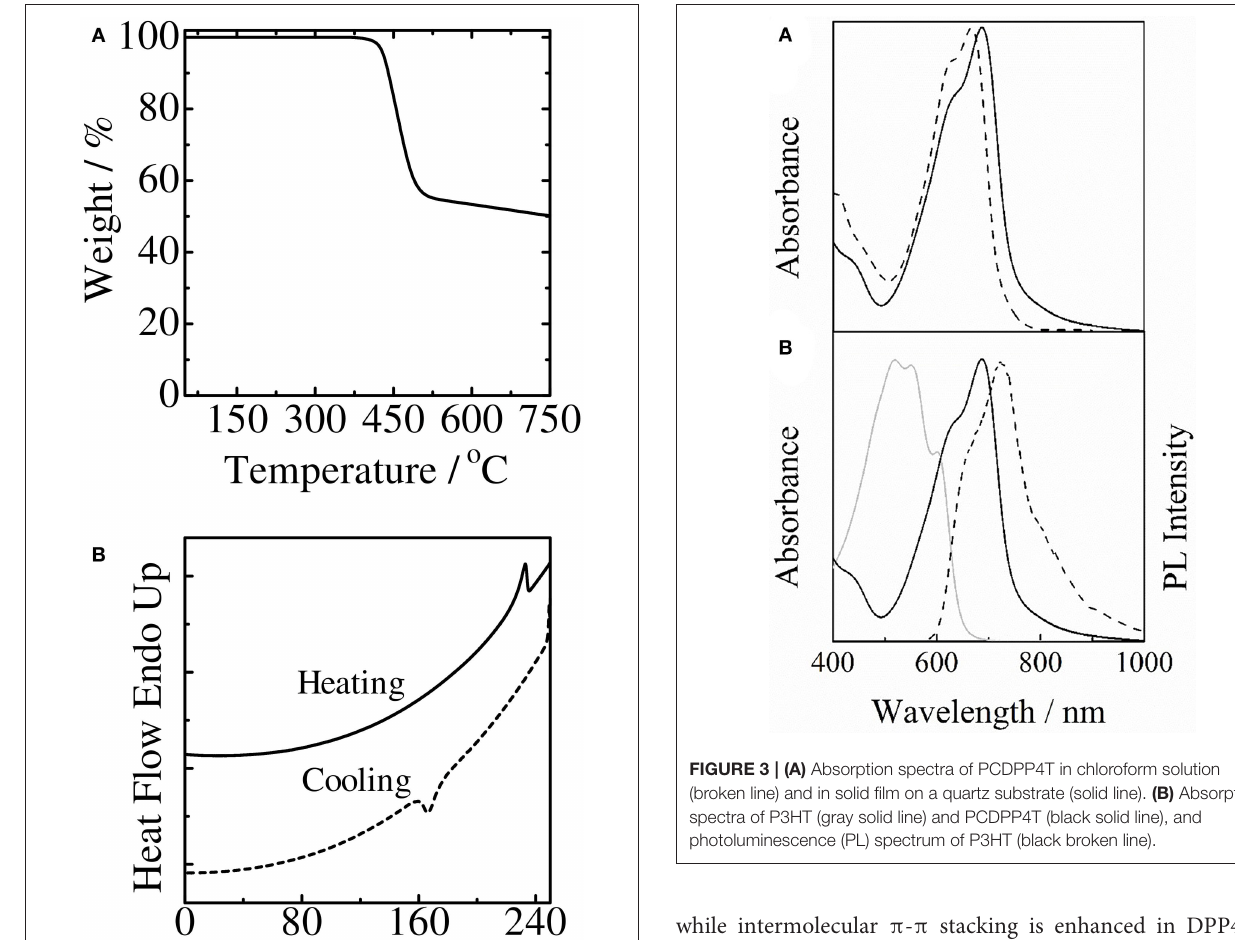
while intermolecular π - π stacking is enhanced in